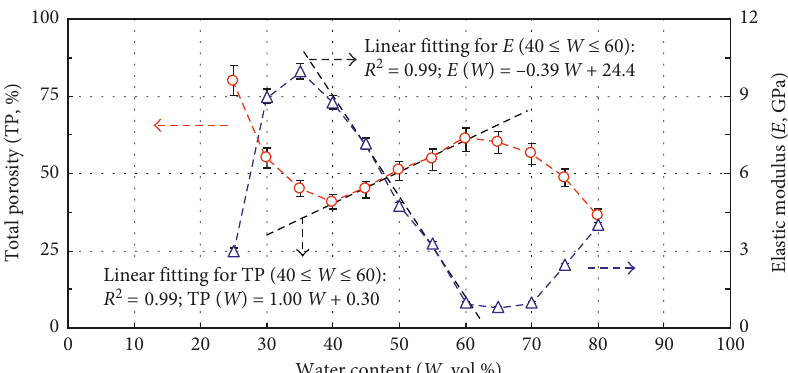
Figure 3: Effects of water content ( W vol.%) on samples’ total porosity (TP, %) and flexural elastic modulus ( E GPa) after conventional static curing and drying at 120 ° C for